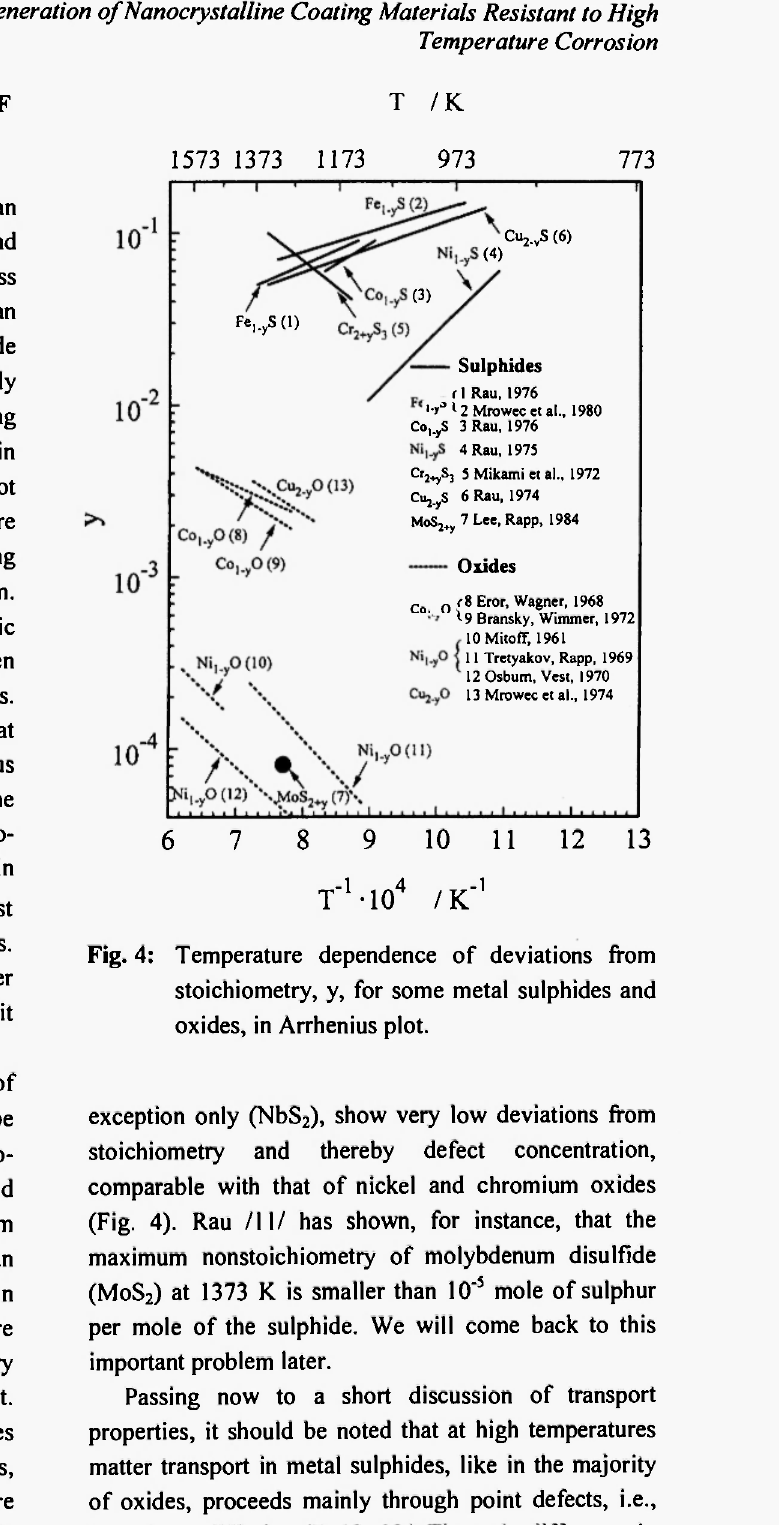
Fig. 4: Temperature dependence of deviations from stoichiometry, y, for some metal sulphides and oxides, in Arrhenius